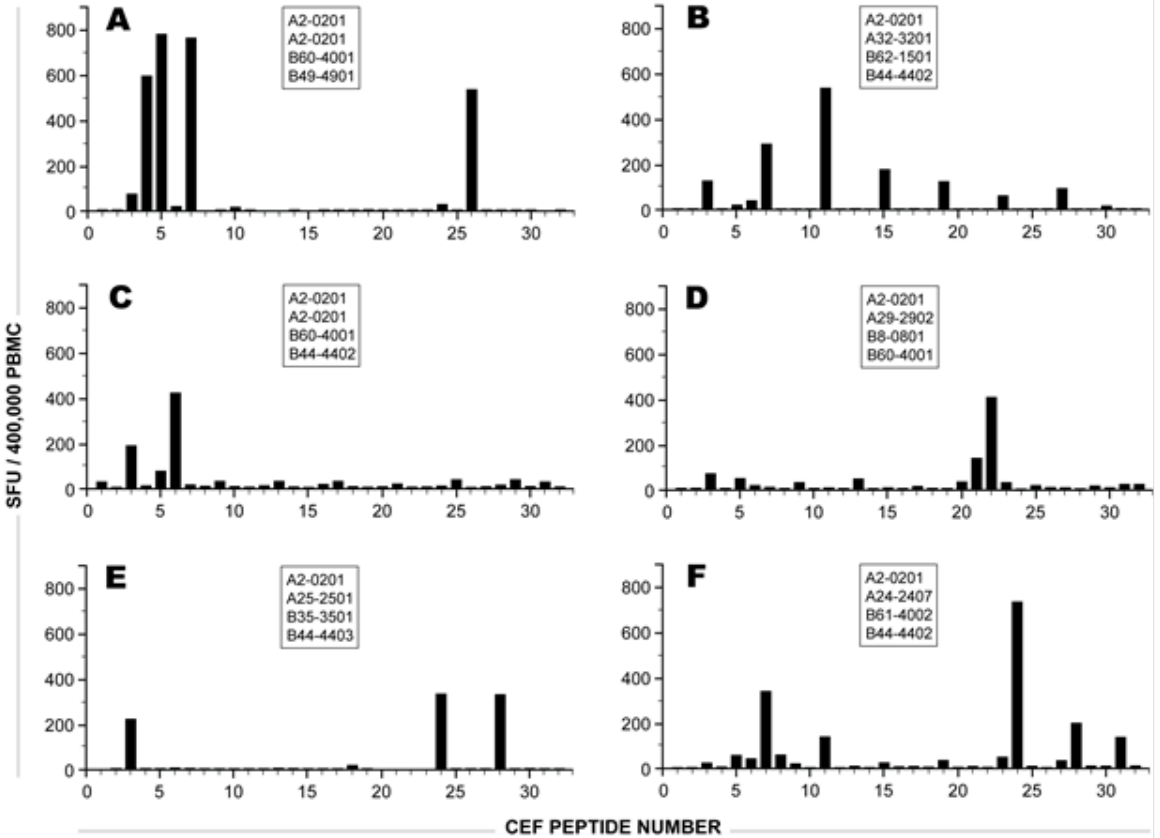
Figure 1. IFN- γ SFU induced by the individual CEF peptides in six HLA -A2-0201 positive donors. The other HLA-A and B alleles expressed by each of these donors are specified in the respective panels. The numbers on the X axis specify the CEF peptide number as defined in Table 1. The bars show the mean number of SFU elicited by each CEF peptide in an IFN- γ ELISPOT assay at 1 μg/ml final concentration, established in triplicate wells. The SD for each peptide-induced response was less than 20%, and the medium control was less than 10